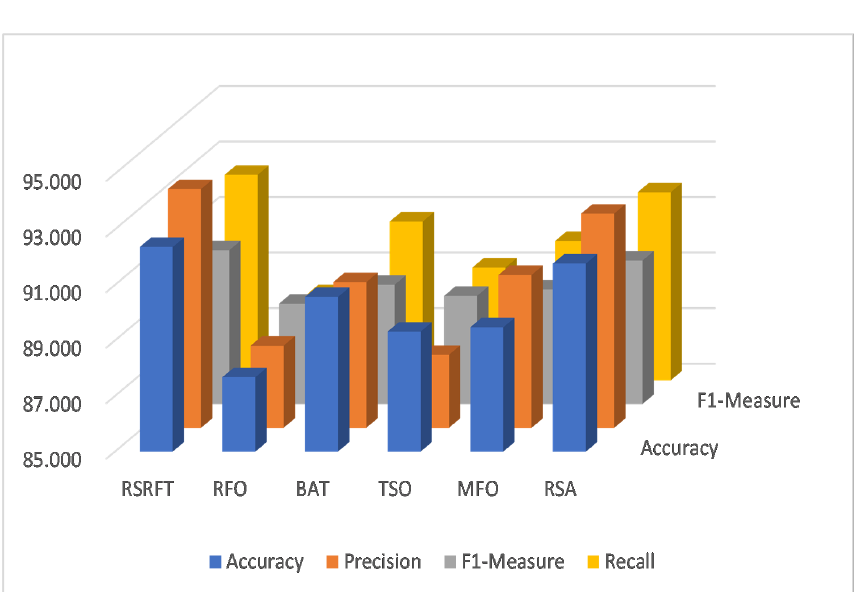
Figure 8. Performance measures of RSRFT using the training